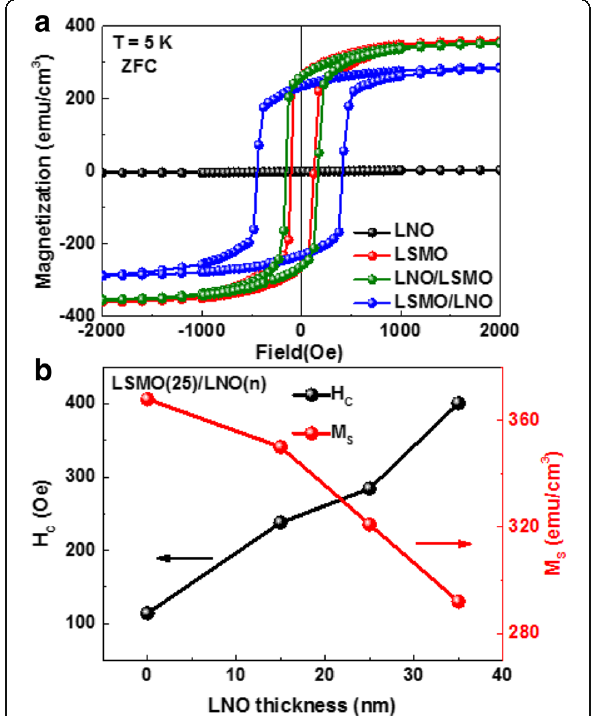
Fig. 2 a Magnetic hysteresis loops of the four different samples at 5 K after zero field-cooling from room temperature. b The H C and M S of LSMO/LNO bilayer dependence on the LNO layer having different thickness. The M S was obtained after saturating at 2 kOe